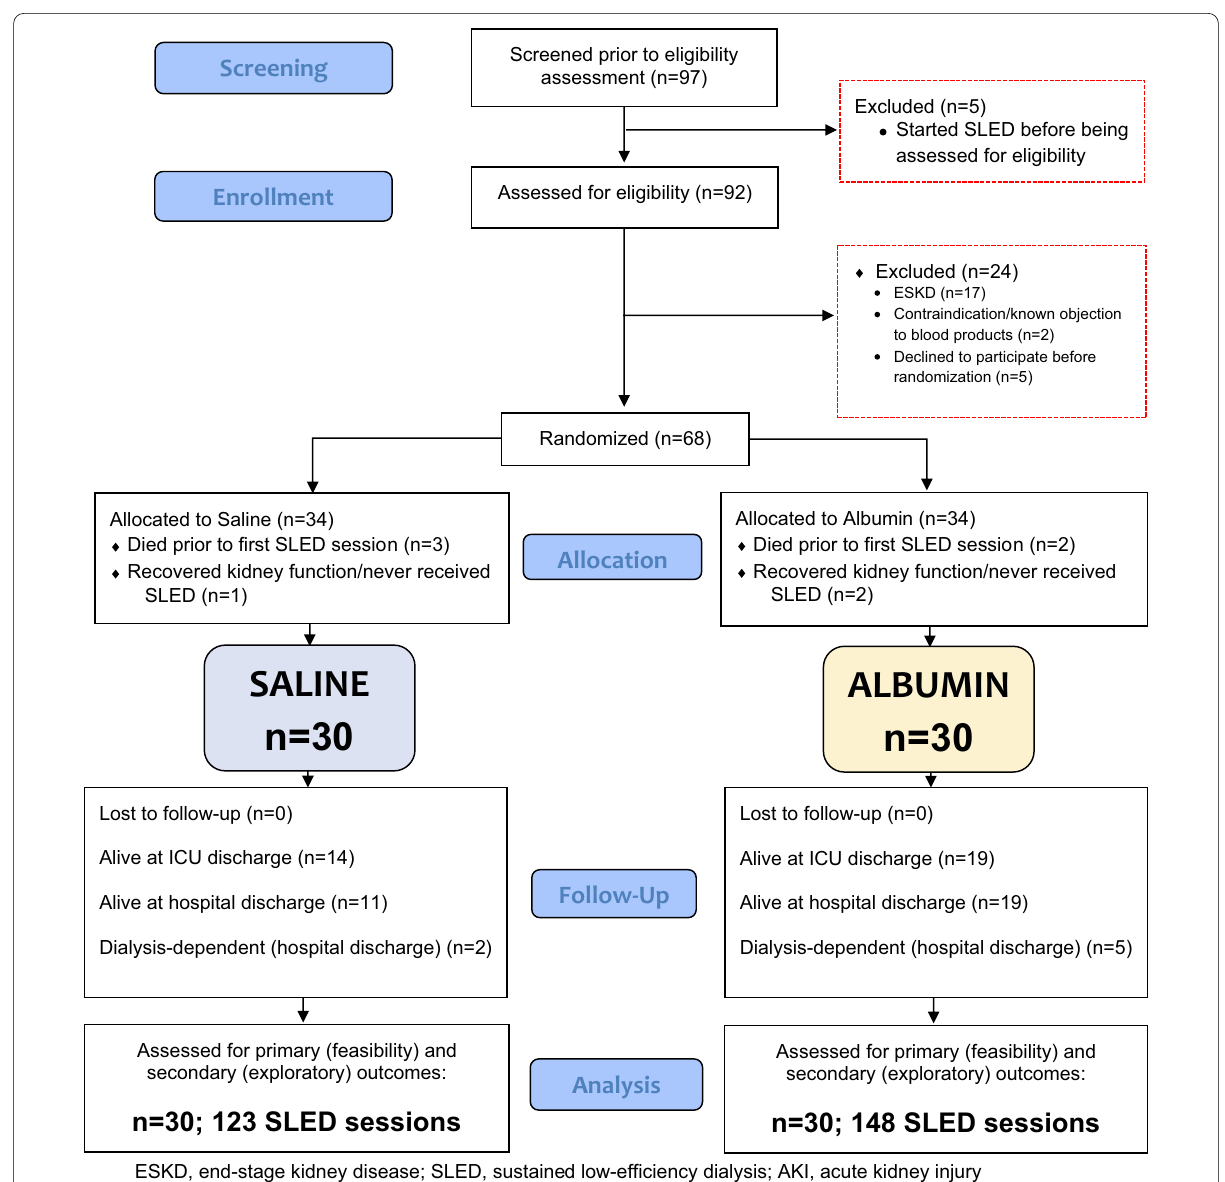
Fig. 1 Study flow diagram. ESKD: end‑stage kidney disease; SLED: sustained low‑efficiency dialysis; AKI: acute kidney injury. See Table 2 for additional details regarding protocol